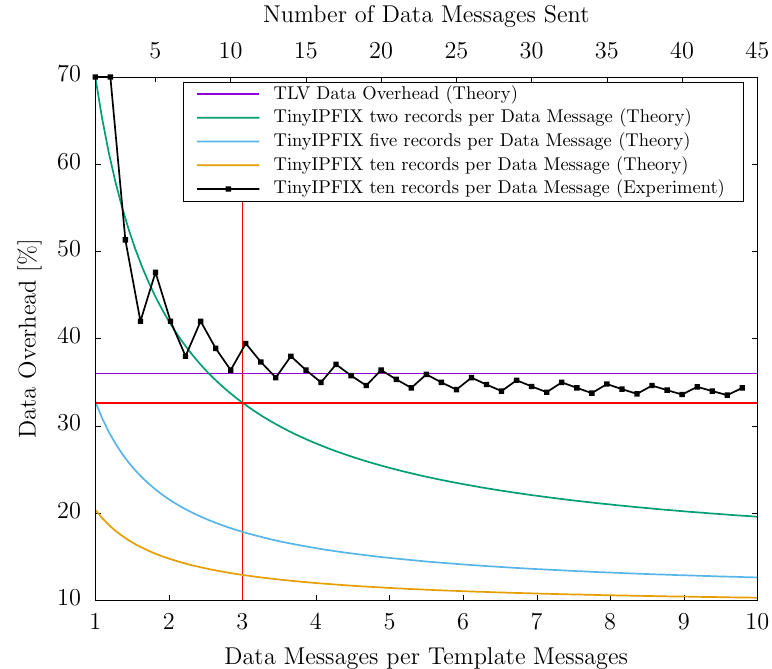
Figure 5. TinyIPFIX and TLV Overhead